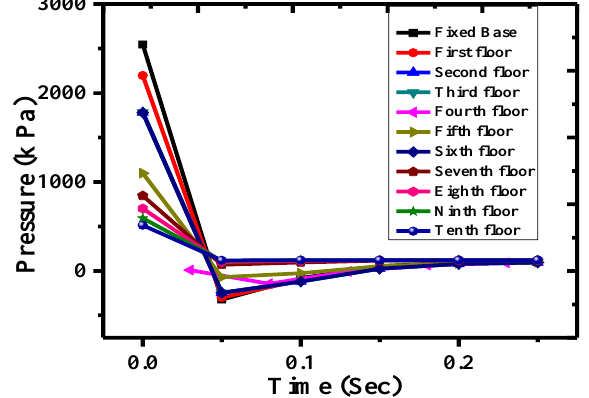
Fig. 3. Blast load acting on 10 storey